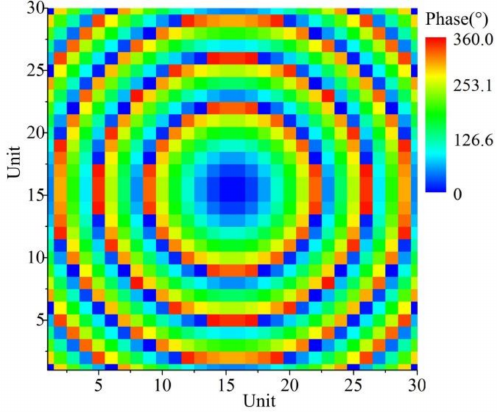
Figure 8. Phase-shift distribution on the reflectarray surface.